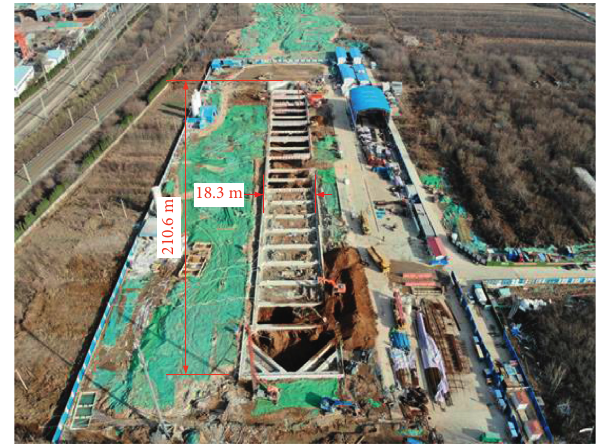
Figure 3: Station